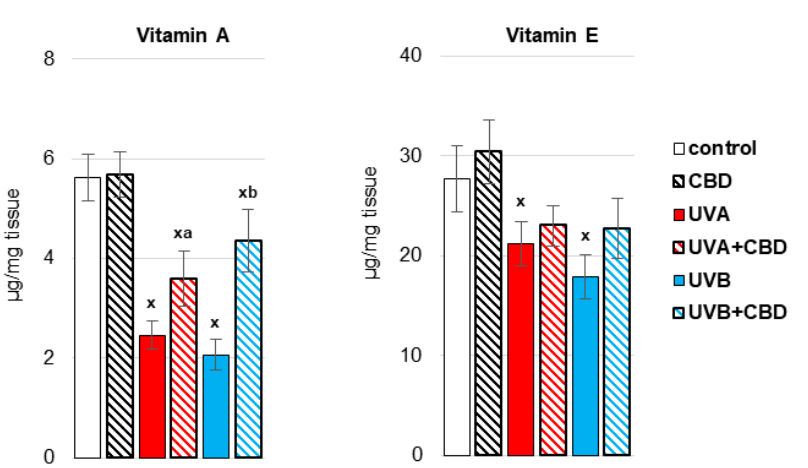
Figure 3. The level of non-enzymatic antioxidants (Vitamin A, Vitamin E) in the liver of nude rats in the following groups: treated with CBD (every 12 h) for 4 weeks; irradiated with UVA (every 48 h) and treated with CBD (every 12 h) for 4 weeks; irradiated with UVB (every 48 h) and treated with CBD (every 12 h) for 4 weeks. The mean values for six rats in each group ± SD are shown: x—differences vs. control group, p < 0.05; a—differences vs. UVA treated group, p < 0.05; b—differences vs. UVB treated group, p < 0.05.